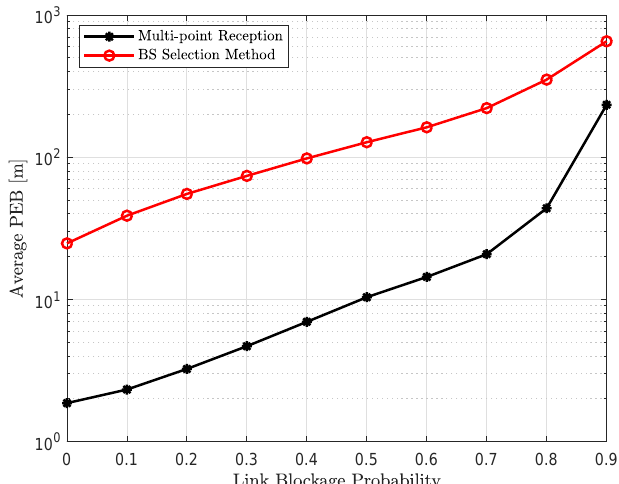
Figure 5. Average positioning accuracy as a function of increasing link blockage probability P b with the uplink transmit power P t = 15 dBm.